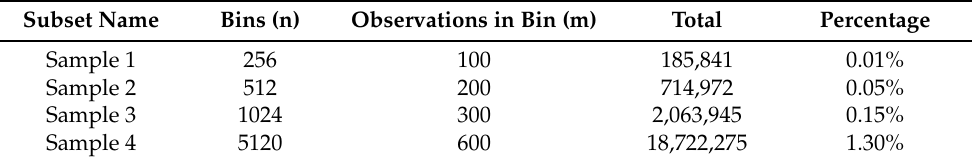
Table 2. Representative Training Samples. n represents the number of bins, m represents the number of pixels sampled in each bin, and the Total represents the total pixels sampled for each